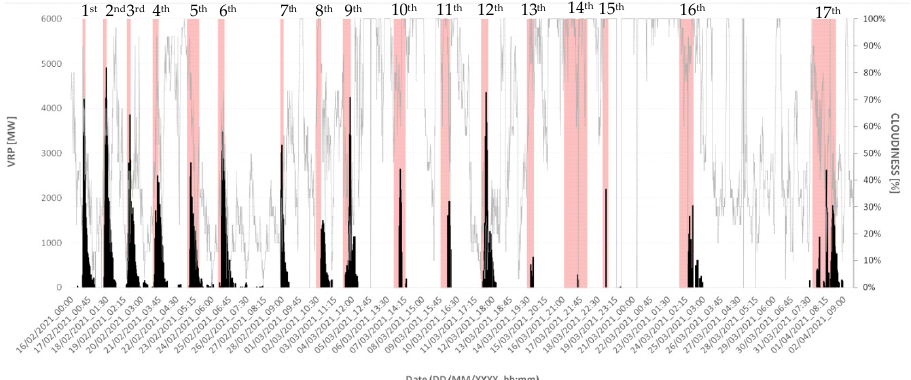
Figure 7. Temporal trend of VRP retrieved from SEVIRI (in black) data (at 15 min time interval) starting from RST VOLC detections with the indication of the number of the Mt. Etna paroxysms. Paroxysms’ time duration (light pink bars) and cloudiness percentage (light grey line) are represented as well.